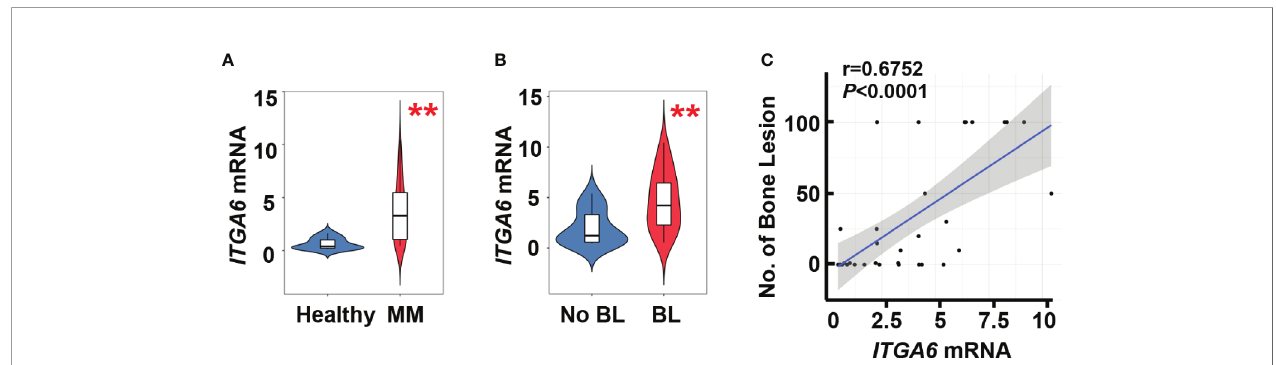
FIGURE 1 | Integrin a 6 is positively associated with lytic lesions in myeloma patients. (A) Quantitative PCR analysis of ITGA6 mRNA levels in normal plasma cells from healthy donors (n = 10) and malignant plasma cells from myeloma patients (MM, n = 34). (B) ITGA6 mRNA levels in malignant plasma cells of 13 myeloma patients without bone lesion (BL = 0) and 21 myeloma patients with bone lesion (BL ≥ 1). Data shown as averages ± SD. ** P < 0.01. P values were determined by Student ’ s t test (A, B) . (C) Correlation coef fi cient of the mRNA levels of ITGA6 and numbers of bone lesion in myeloma patients (n = 34). The correlations were evaluated using Pearson coef fi cient. r, correlation coef fi cient. P value was determined by Pearson coef fi